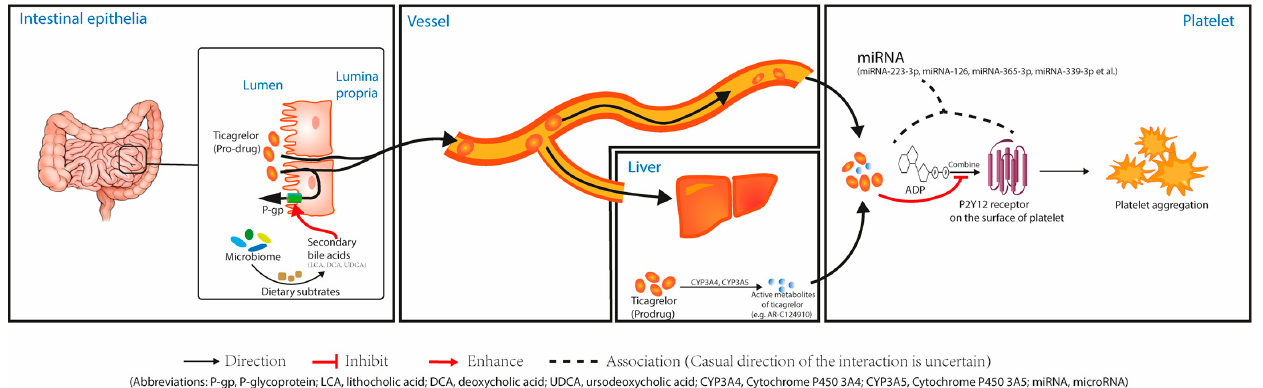
Figure 2. Pharmacokinetics and pharmacodynamics of ticagrelor and the factors impacting the